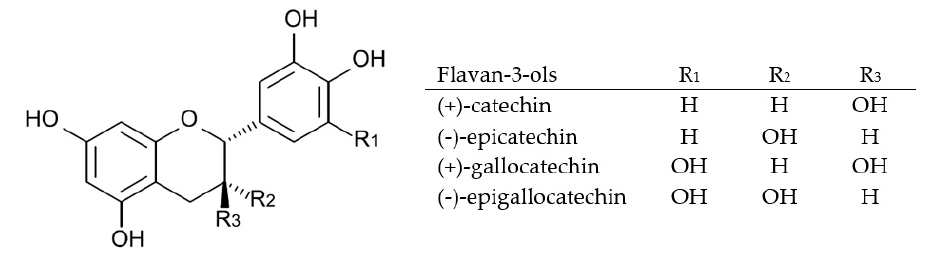
Figure 5. Structure of flavan-3-ols.